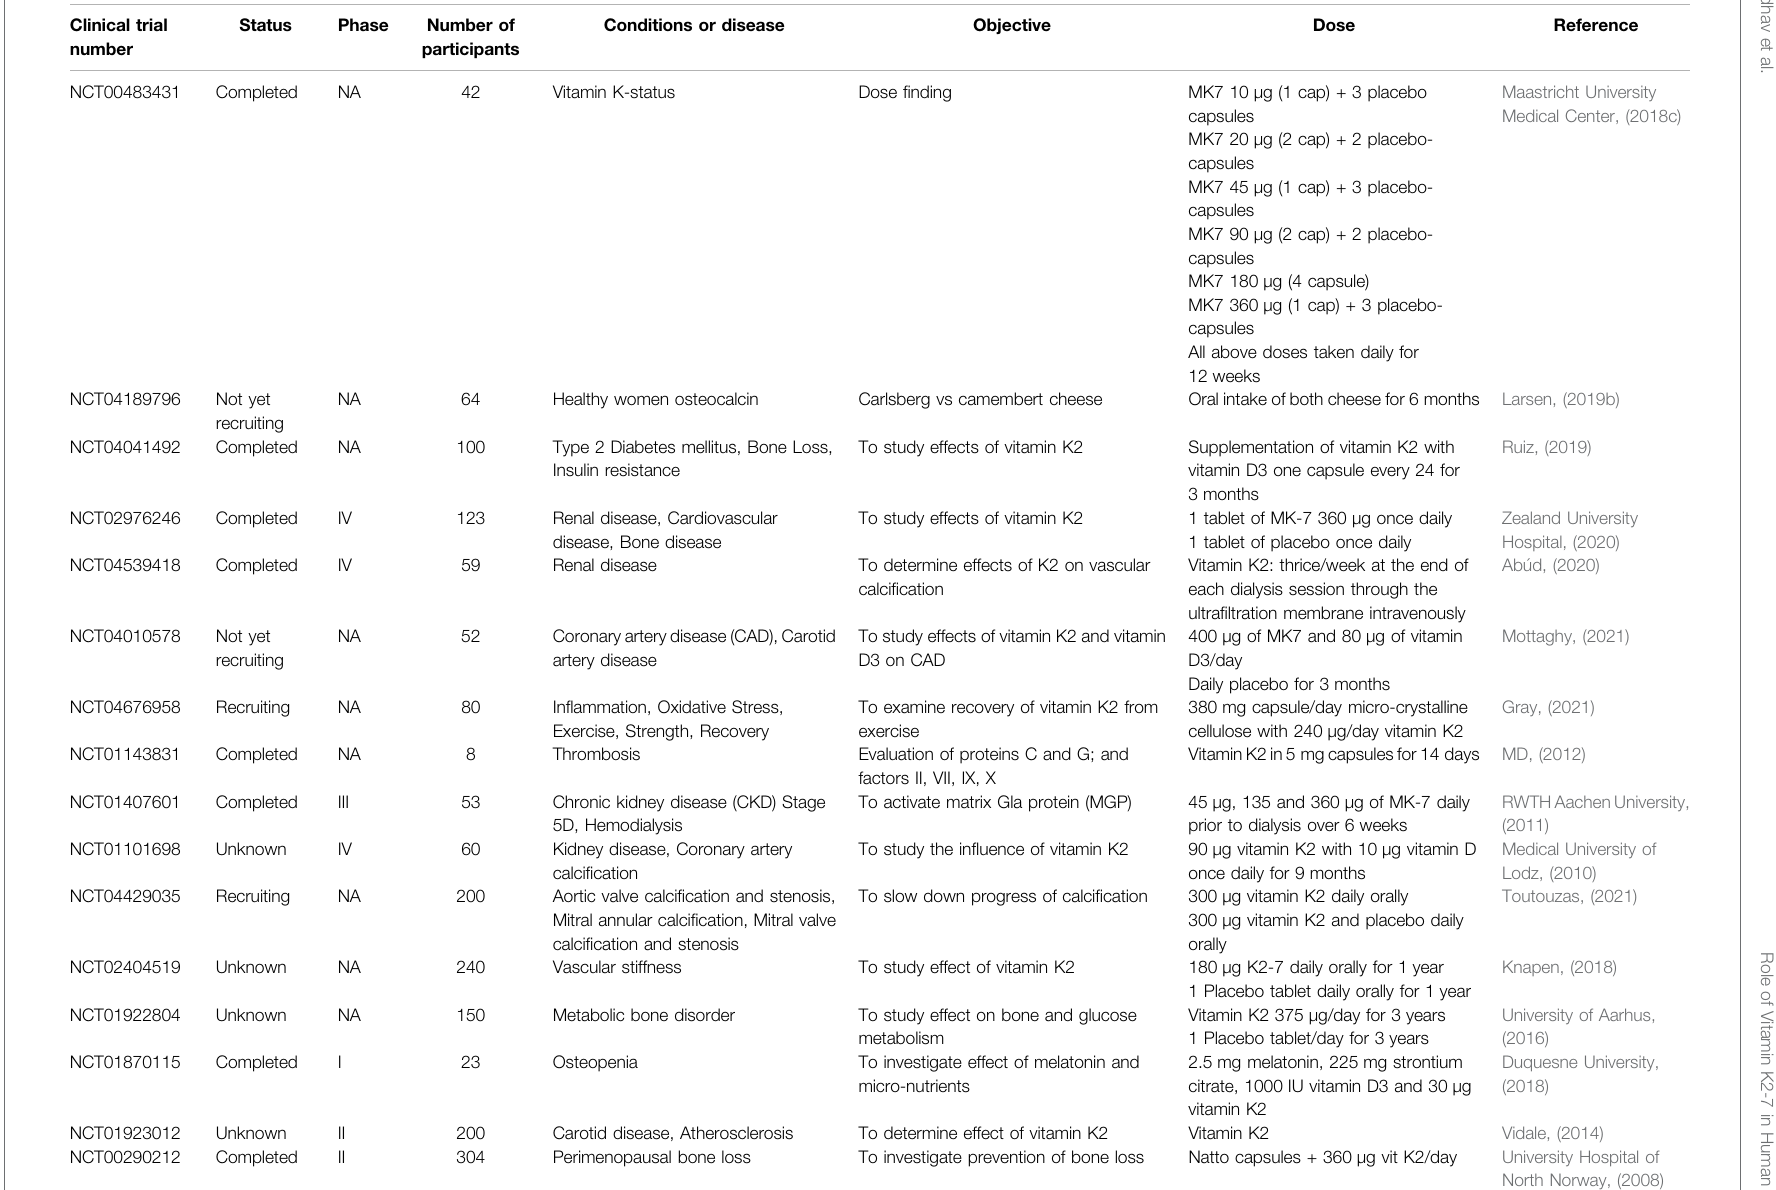
TABLE 3 | ( Continued ) Clinical trials on vitamin K2-7 in the United States of America (Adapted from